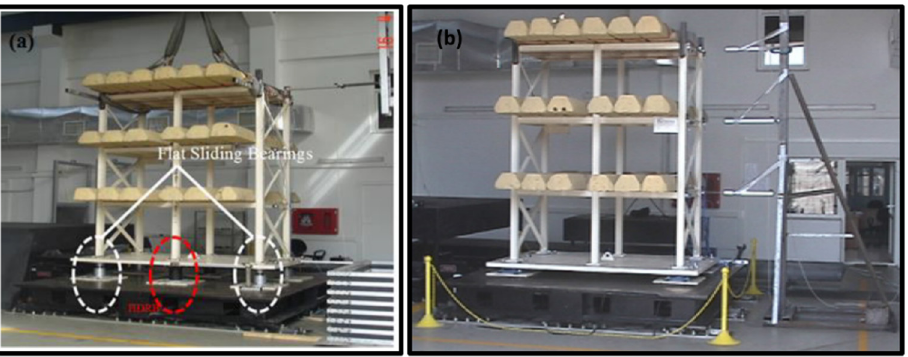
Figure 28. ( a ) Shake table test of a hybrid passive control system [10,106]. ( b ) Test of a traditional CSFS under mass concentric and eccentric cases